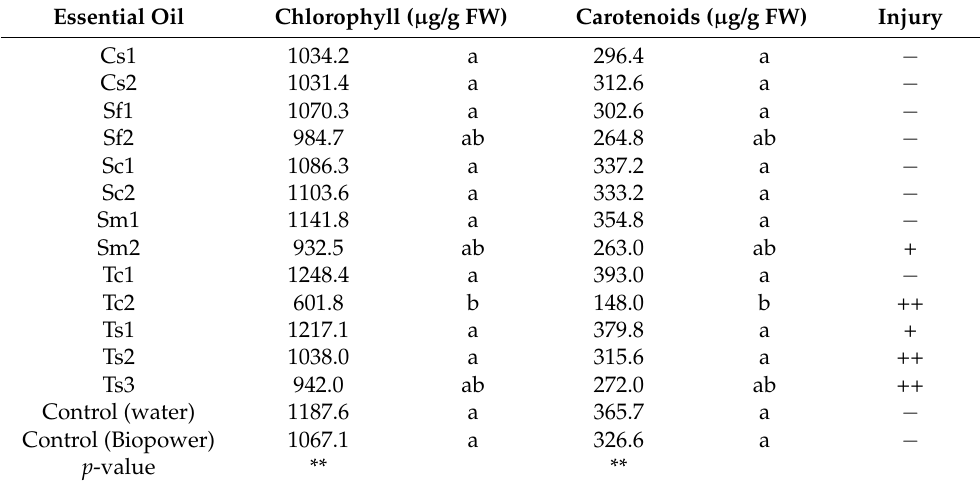
Table 5. Total chlorophyll and carotenoids content and injury rating from Chenopodium album leaf disks exposed to 0.2% of essential oil supplemented with Biopower. Data are expressed as mean of three replicates of 10 leaf disks each, in comparison with the control.